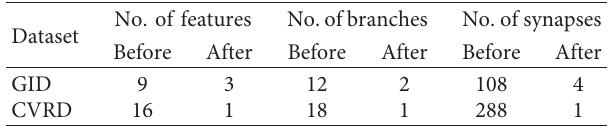
Table 9: Simplification results of neuron pruning on GID and CVRD problems. Dataset